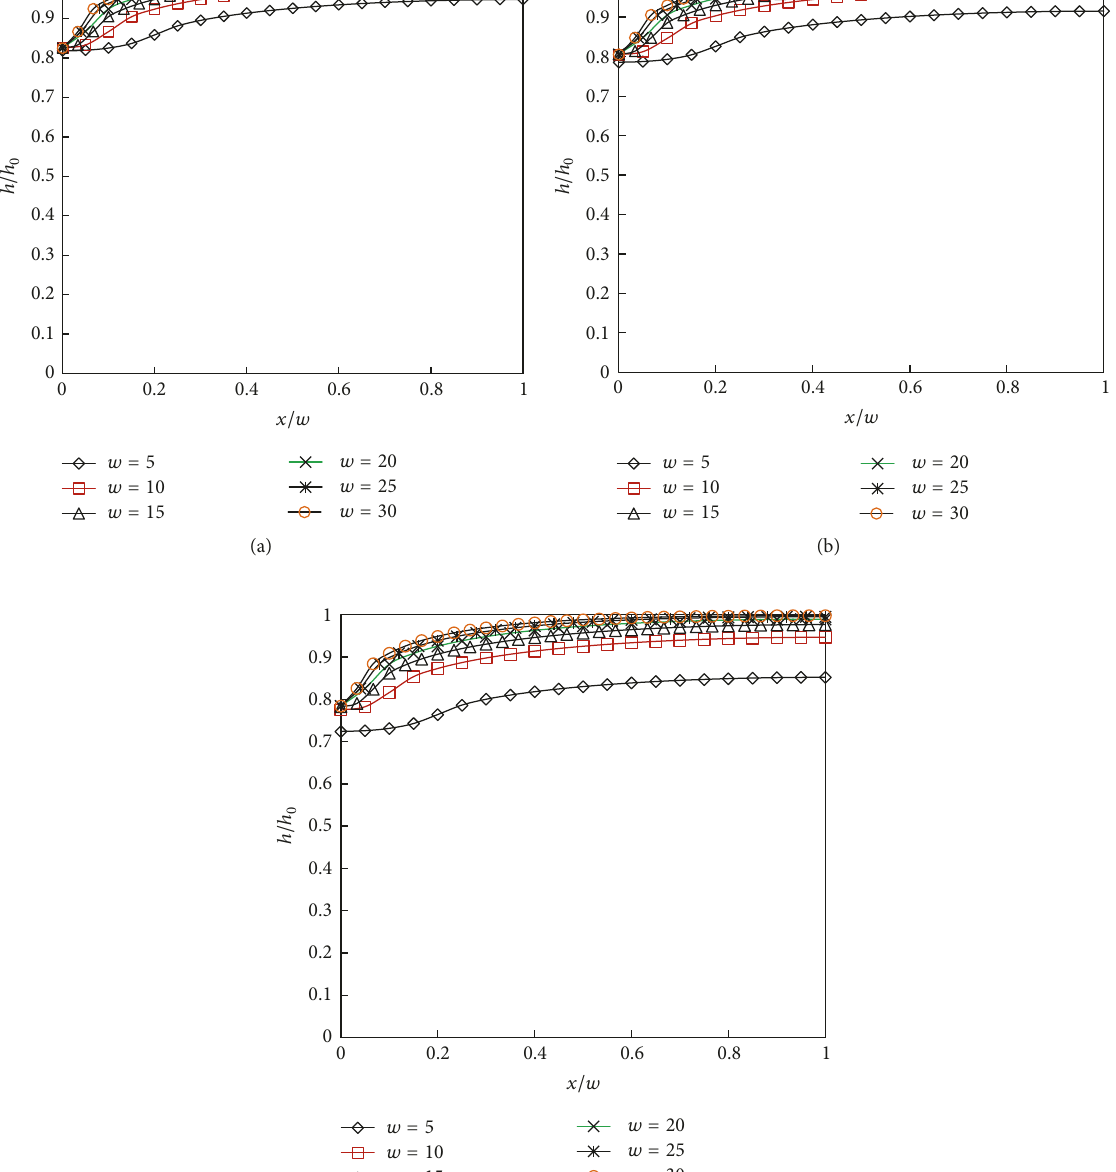
When 𝑘 𝑠 = 1 × 10 −5 m/s for a typical silty soil, after 𝑡 = 80 h, the settlement of the ground surface appears to have